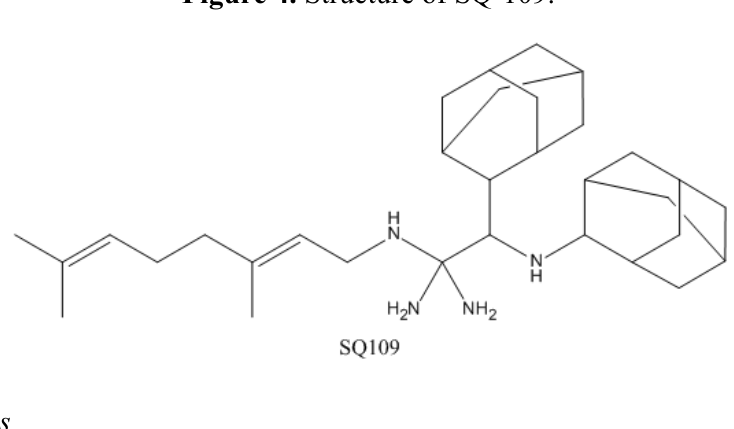
Figure 4. Structure of SQ-109.